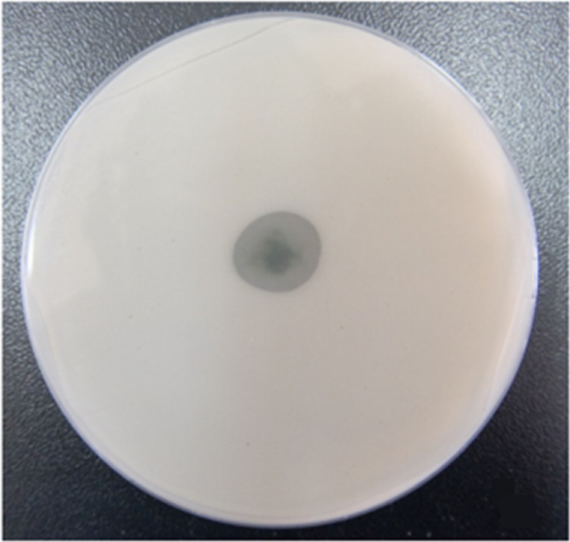
Figure 3. Potassium absorbable ability of LX-7 strain.